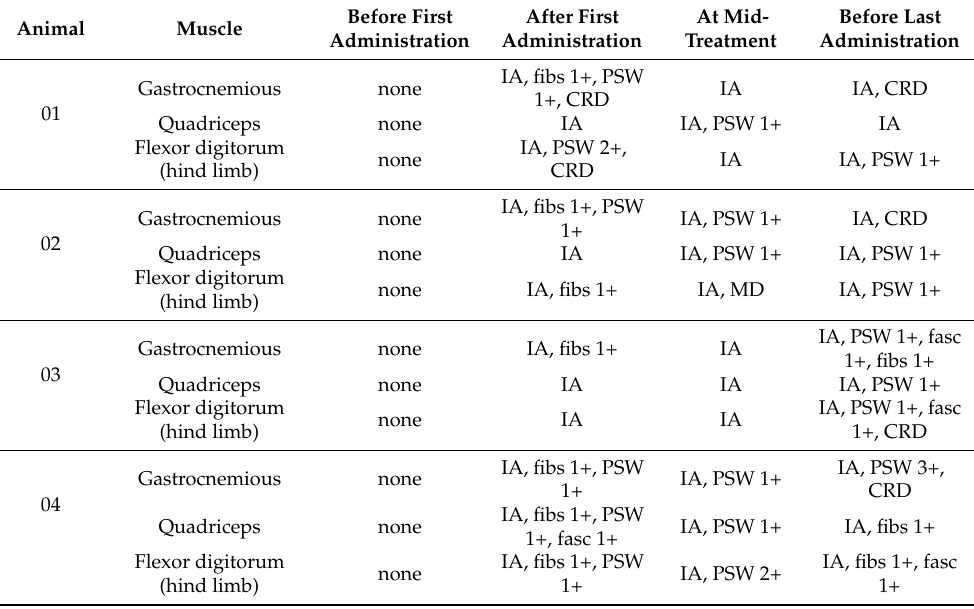
Table 2. EMG findings for animals treated with oxaliplatin (OHP) at different time